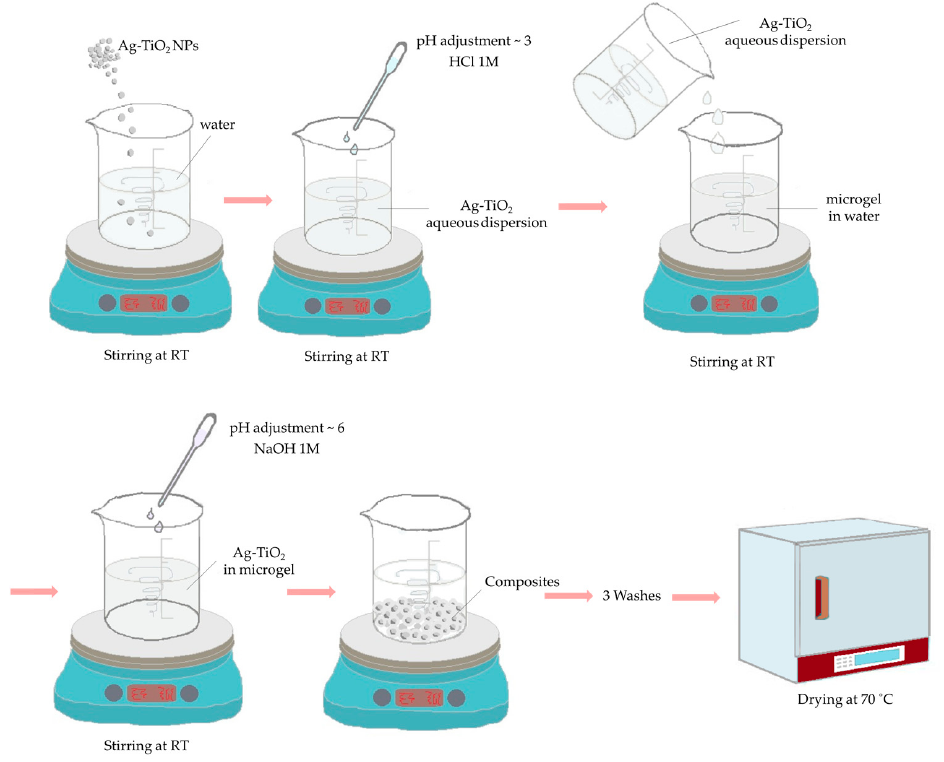
Figure 3. Schematic representation of the synthesis of composite